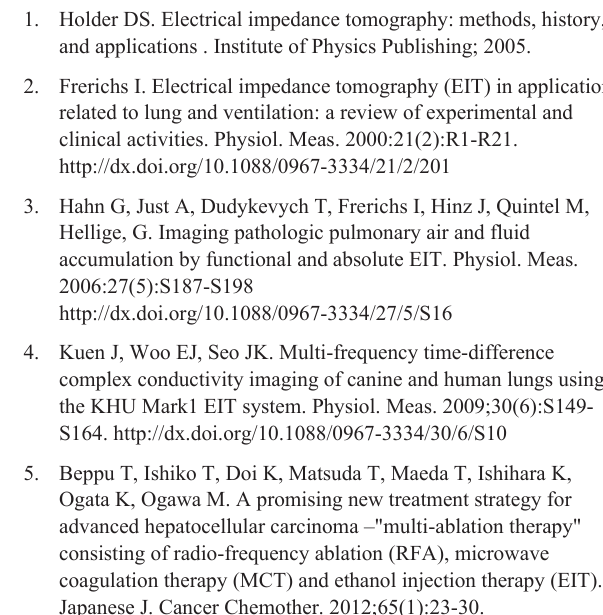
on top of each channel in grey.